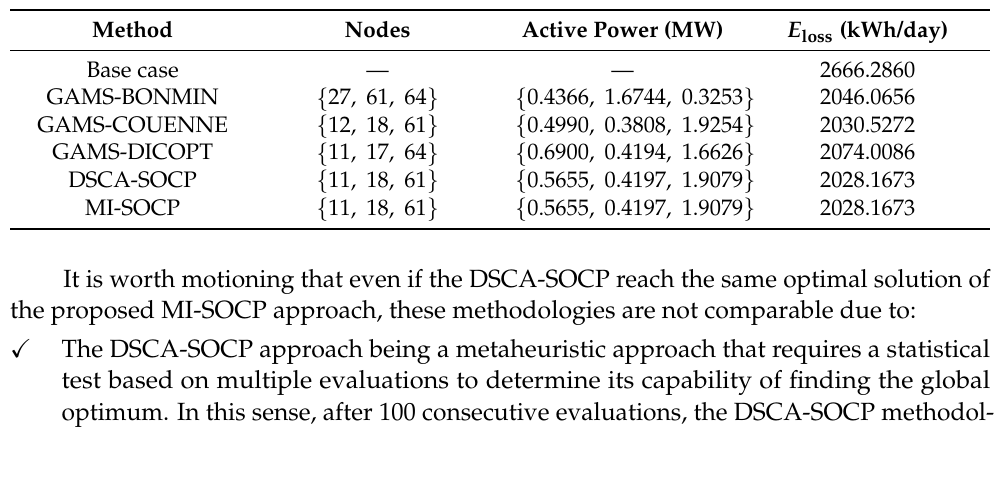
Table 4. Optimal placement and sizing of renewables considering daily curves in the IEEE 69-node test